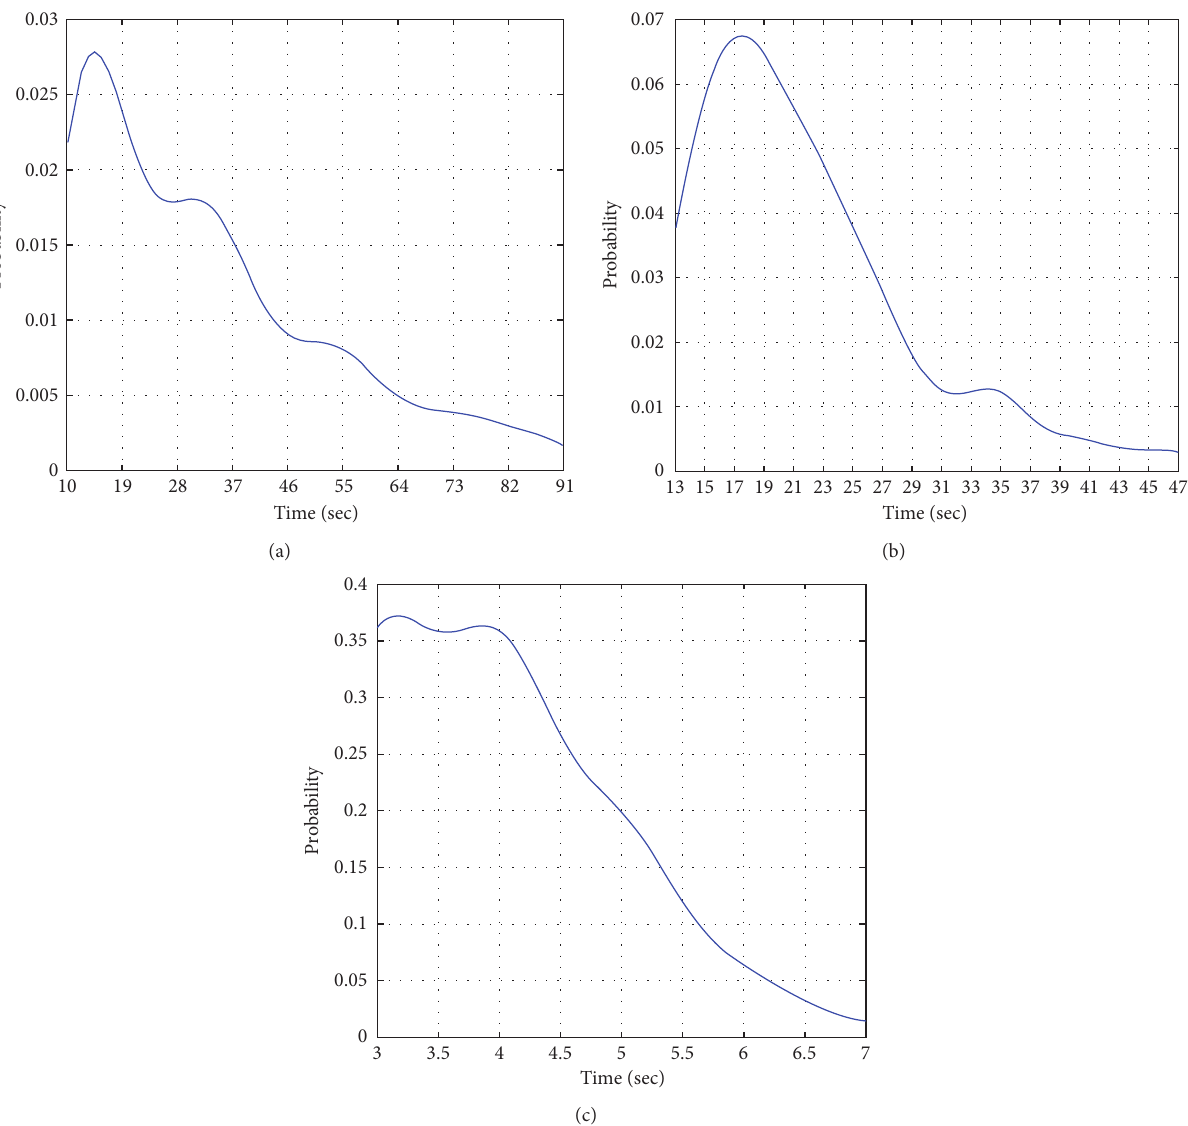
Figure 5: Probability densities of service times at toll plaza. (a) Probability density of car plate automatically verified plus QR code paid time. (b) Probability density of car plate automatically verified plus cash paid time. (c) Probability density of car plate automatically time.